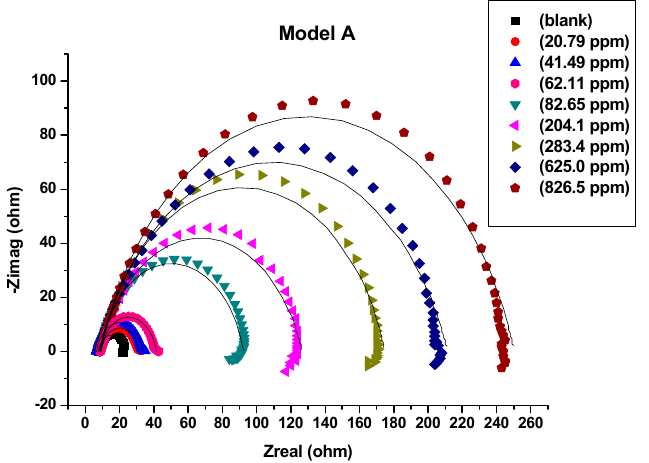
Molecules 2021 , 26 , x FOR PEER REVIEW 10 of 21 Figure 5. Nyquist plots in 0.25 M H 2 SO 4 , fitted by equivalent circuit model A for all concentrations of Harmal extract (0, 20.79, 41.49, 62.11, 82.65, 204.1, 283.4, 625.0 and 826.5 ppm).